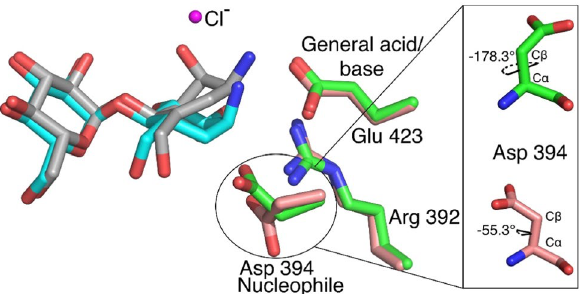
Figure 8. Superimposed active sites of Sco GlgE1-V279S/ 7 and Sco GlgE1-V279S/ 8 structures.